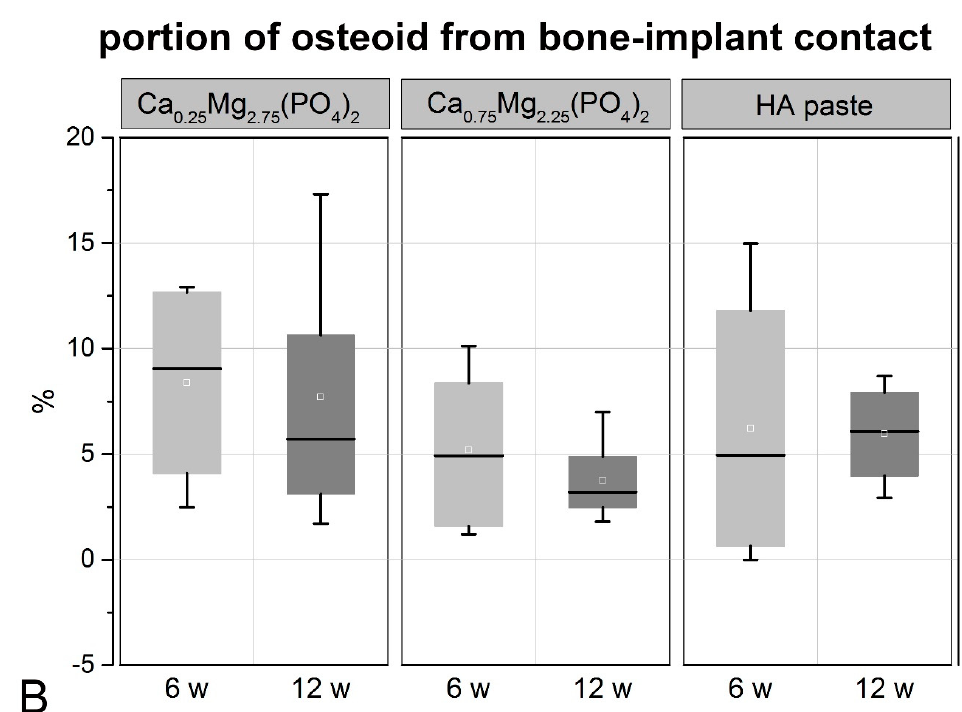
Figure 6. Bone-implant contact ( A ) and the portion of osteoid from bone-implant contact ( B ) determined from histological sections 6 and 12 weeks after implantation, respectively.